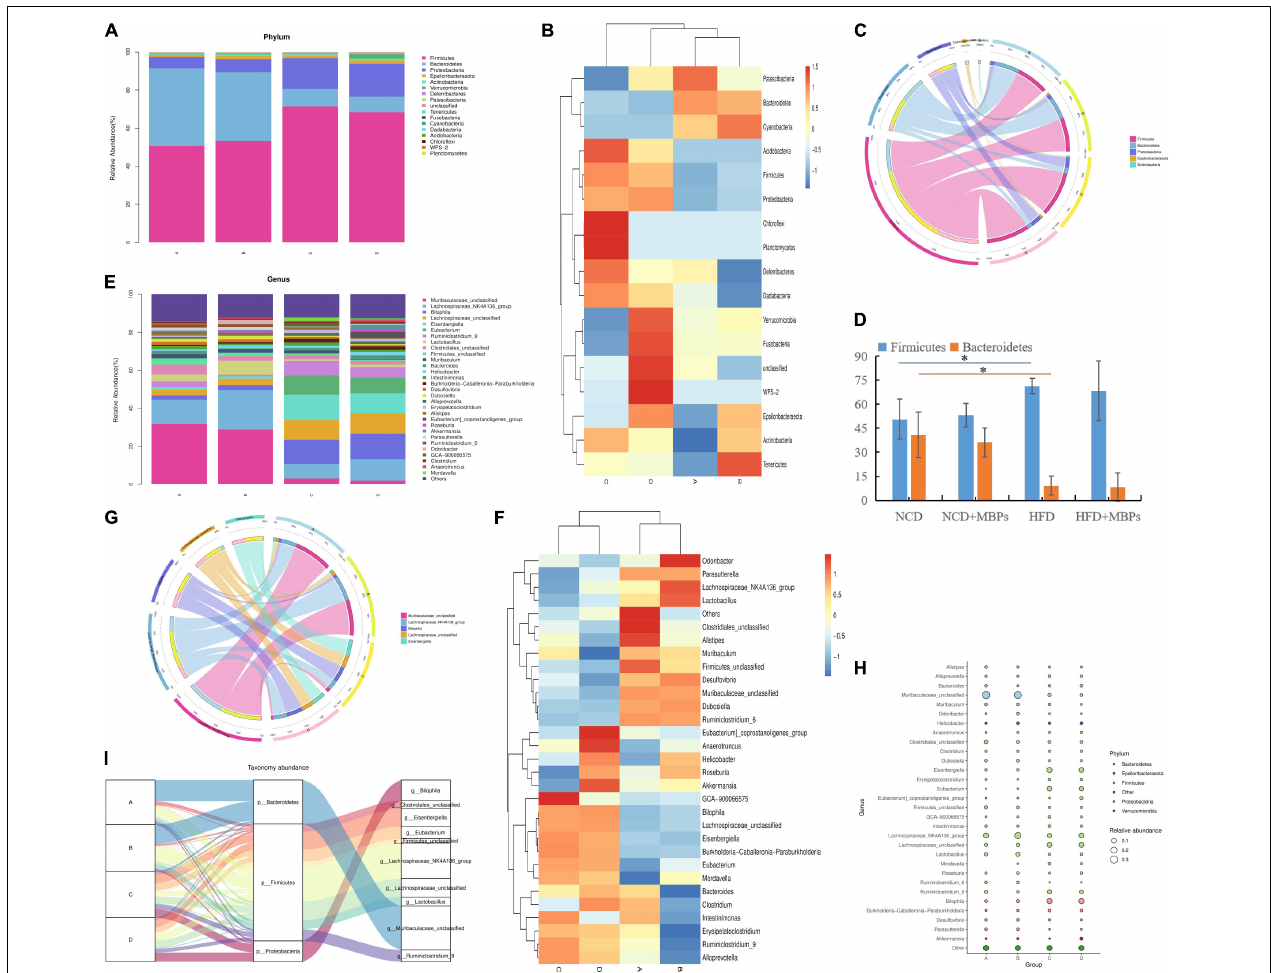
FIGURE 5 | Analysis of intestinal flora species in mice ( n = 6). (A) Phylum abundance group stacked bar. (B) Phylum abundance group heatmap. (C) Phylum circos top 5. (D) The abundance of Firmicutes and Bacteroidetes in each group. (E) Genus abundance group stacked bar. (F) Genus abundance group heatmap. (G) Genus circos top 5. (H) Bubble plot. (I) Sankey genus abundance phylum. In the figure, A, B, C, and D represent NCD, NCD + MBPs, HFD, and HFD + MBPs, respectively. * P < 0.05, NCD compared with